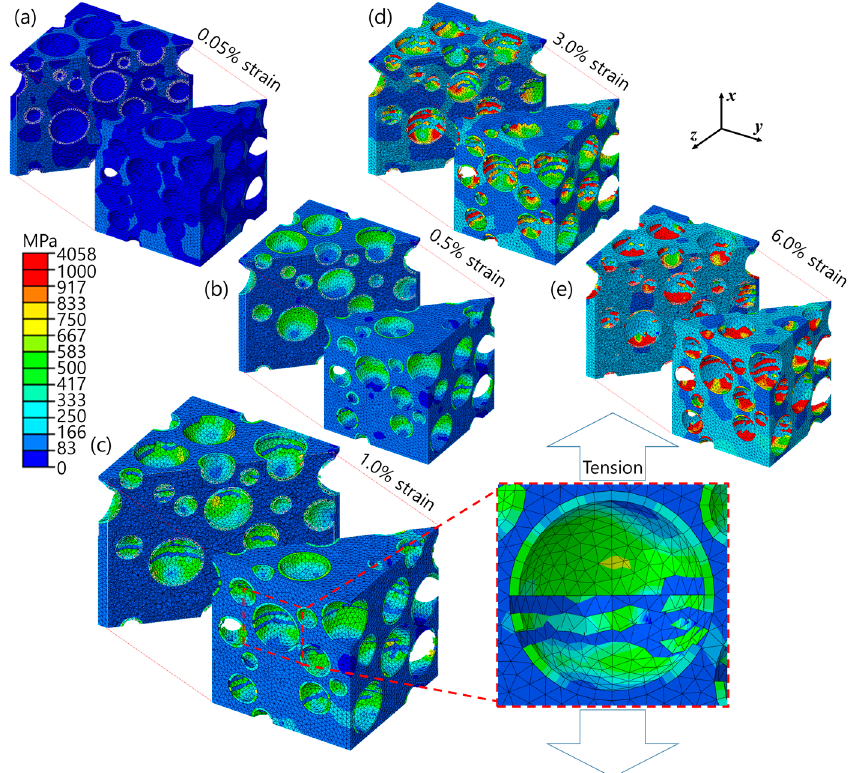
Figure 8. Equivalent stress fields of the L = 55 µ m RVE model subjected to x -axial tensile strain of ( a ) 0.05%; ( b ) 0.5%; ( c ) 1.0%; ( d ) 3.0%; and ( e ) 6.0%.